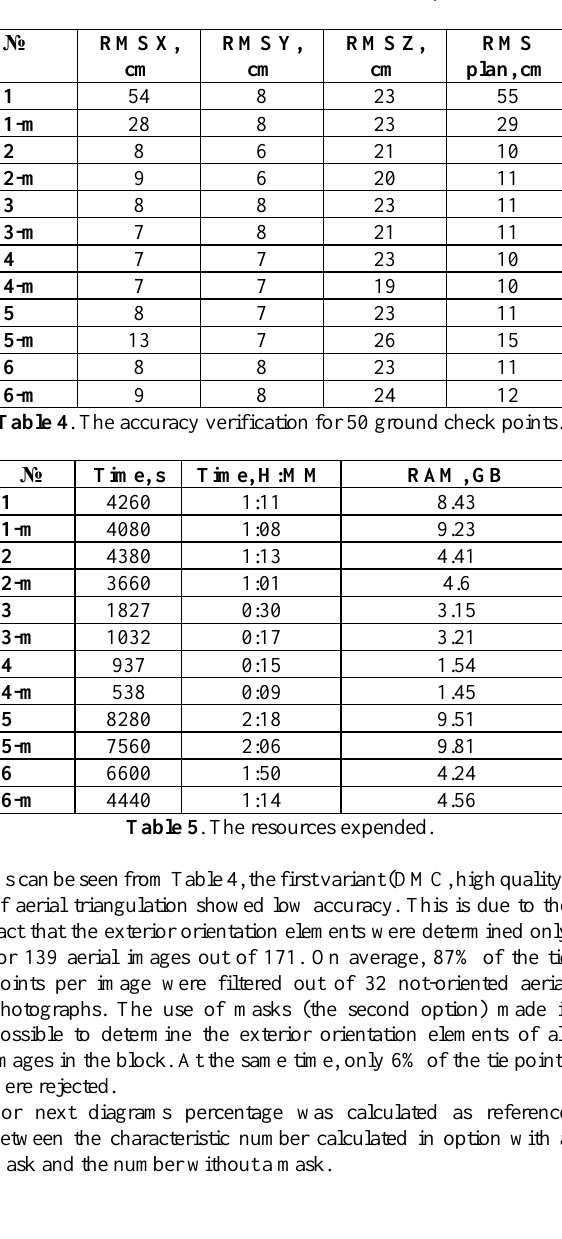
Table 3 . The results of the search for tie points.